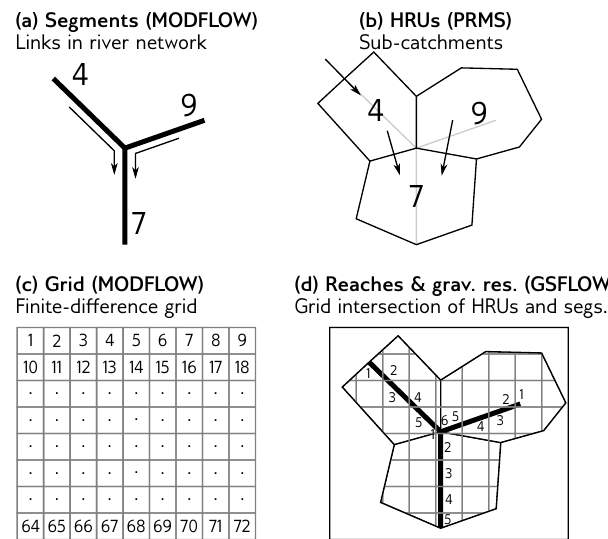
Figure 1. Major features of the GSFLOW–GRASS geometry. (a) Each segment is one link in the network. At each node, two tributary segments combine to flow into a single segment. Each is numbered. They need not be in any particular order, as indicated, but a downstream-increasing numbering scheme is required for up- dated inflows to all segments to be computed during the same iter- ation. (b) Flow in each of the subbasin HRUs is routed directly to a corresponding stream segment. The arrow on the upper left indi- cates that flow from outside of the representative tributary junction may also be part of the drainage network. Our topological approach to defining HRUs allows HRUs to be numbered the same as the stream segments that they enclose. Our code is written in such a way that future developments can relax this symmetry. (c) MOD- FLOW operates on a grid that underlies the PRMS-based stream network and HRUs; each cell has a unique ID that is sequentially numbered. (d) “Gravity reservoirs” are defined by the intersection of the PRMS HRUs and the MODFLOW grid. “Reaches” are de- fined as the section of each PRMS stream segment that lies within a single MODFLOW grid cell and are numbered sequentially down- stream as